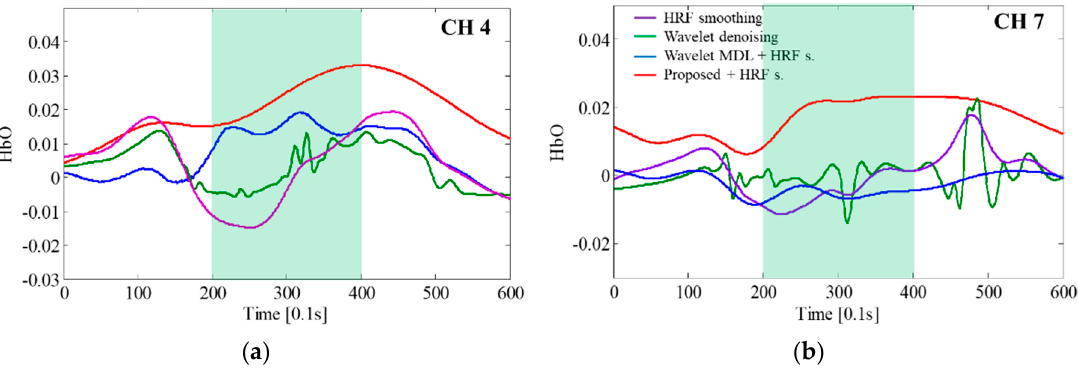
Figure 11. Comparison of the fNIRS signal correction results obtained using the proposed and conventional methods: ( a ) CH 4; ( b ) CH 7.